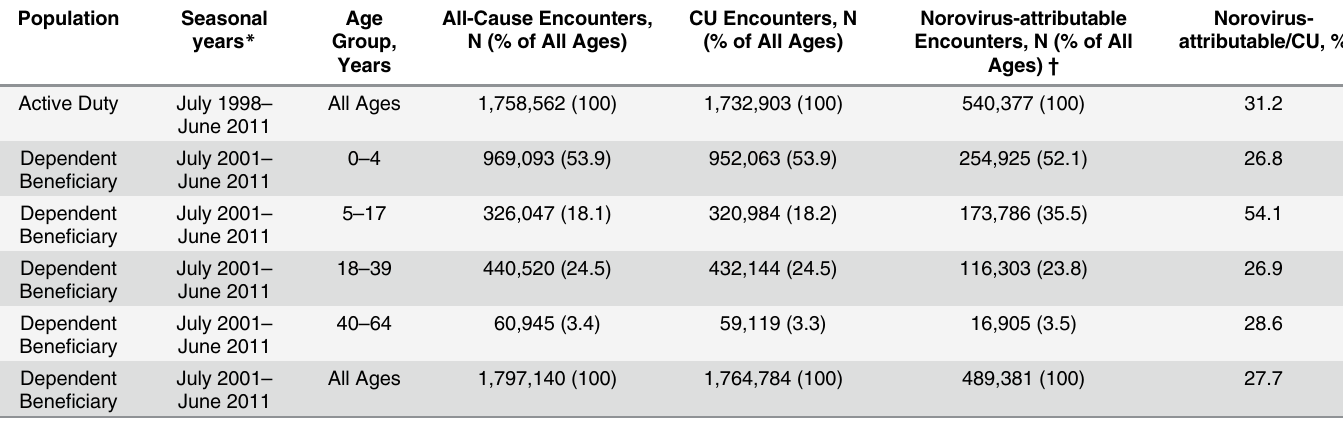
Table 3. All-cause, cause-unspecified (CU) and norovirus-attributable encounters by age group.